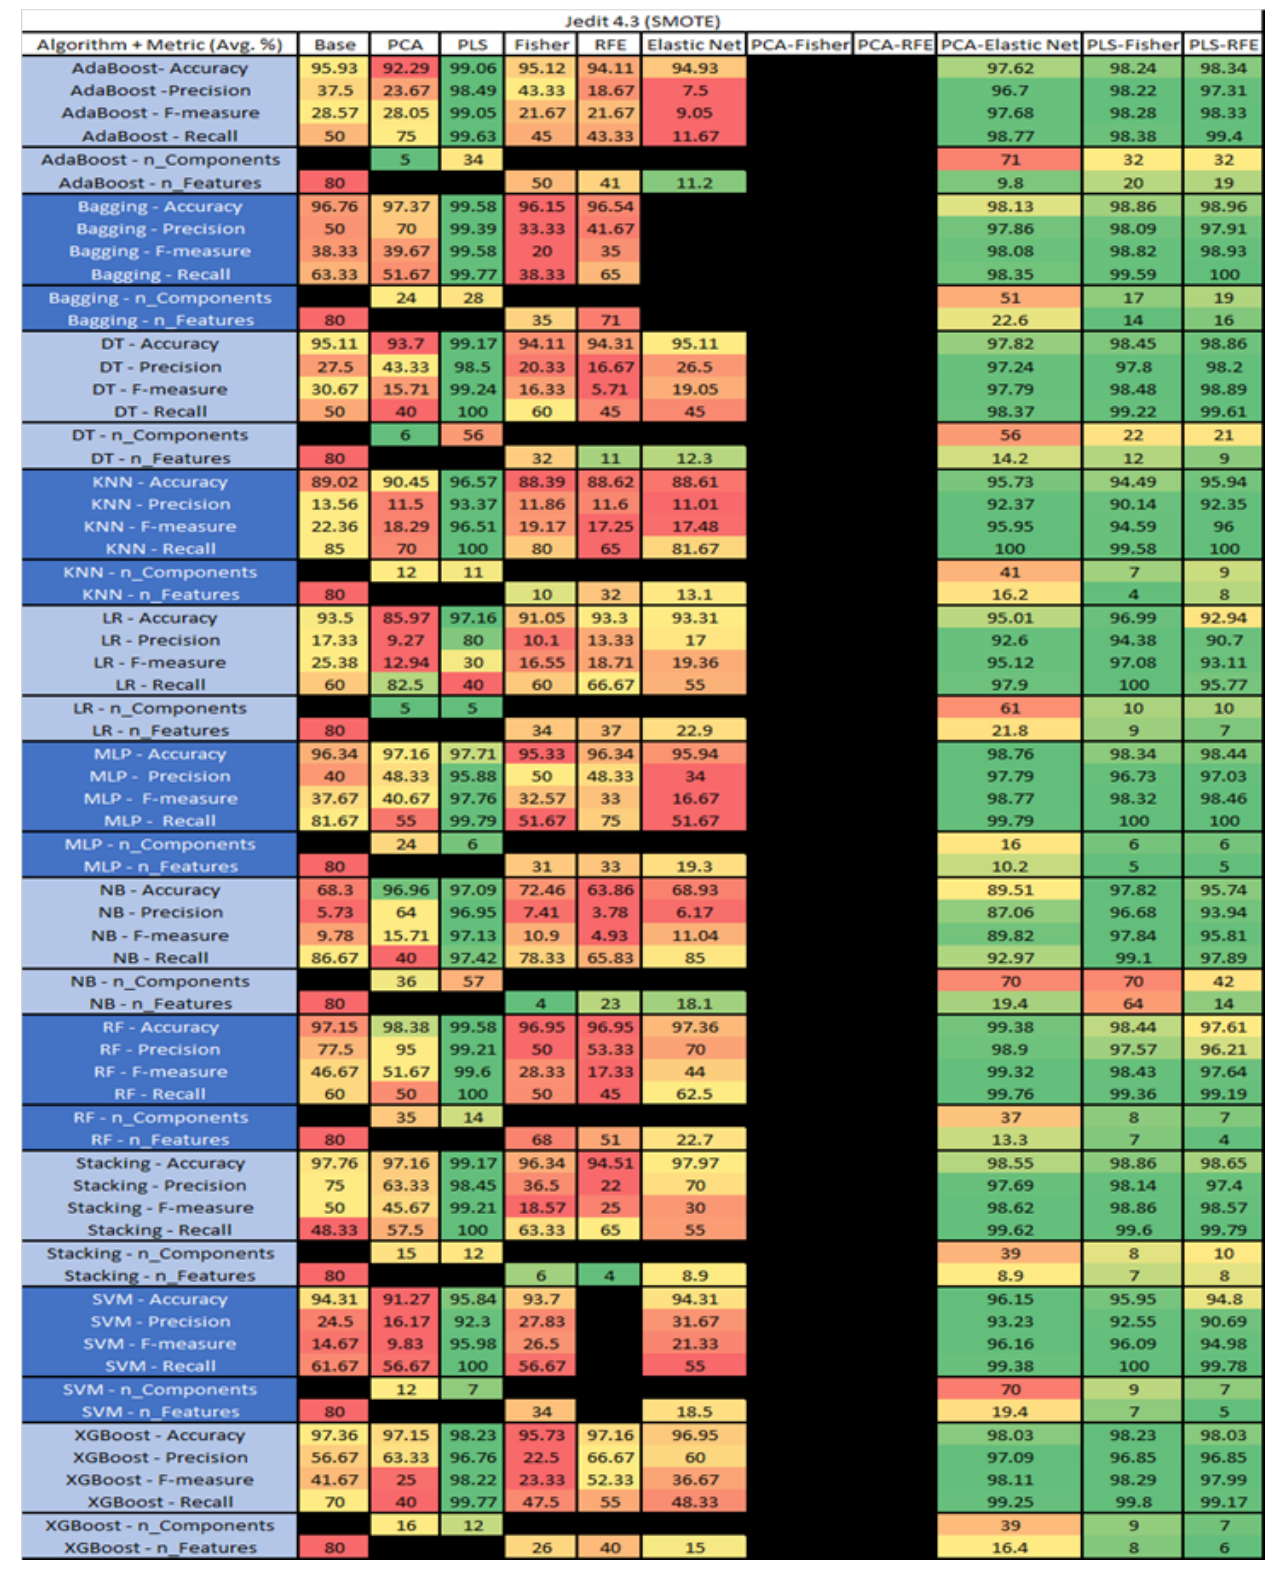
Figure 23. Jedit 4.3 SMOTE PROMISE Results Data